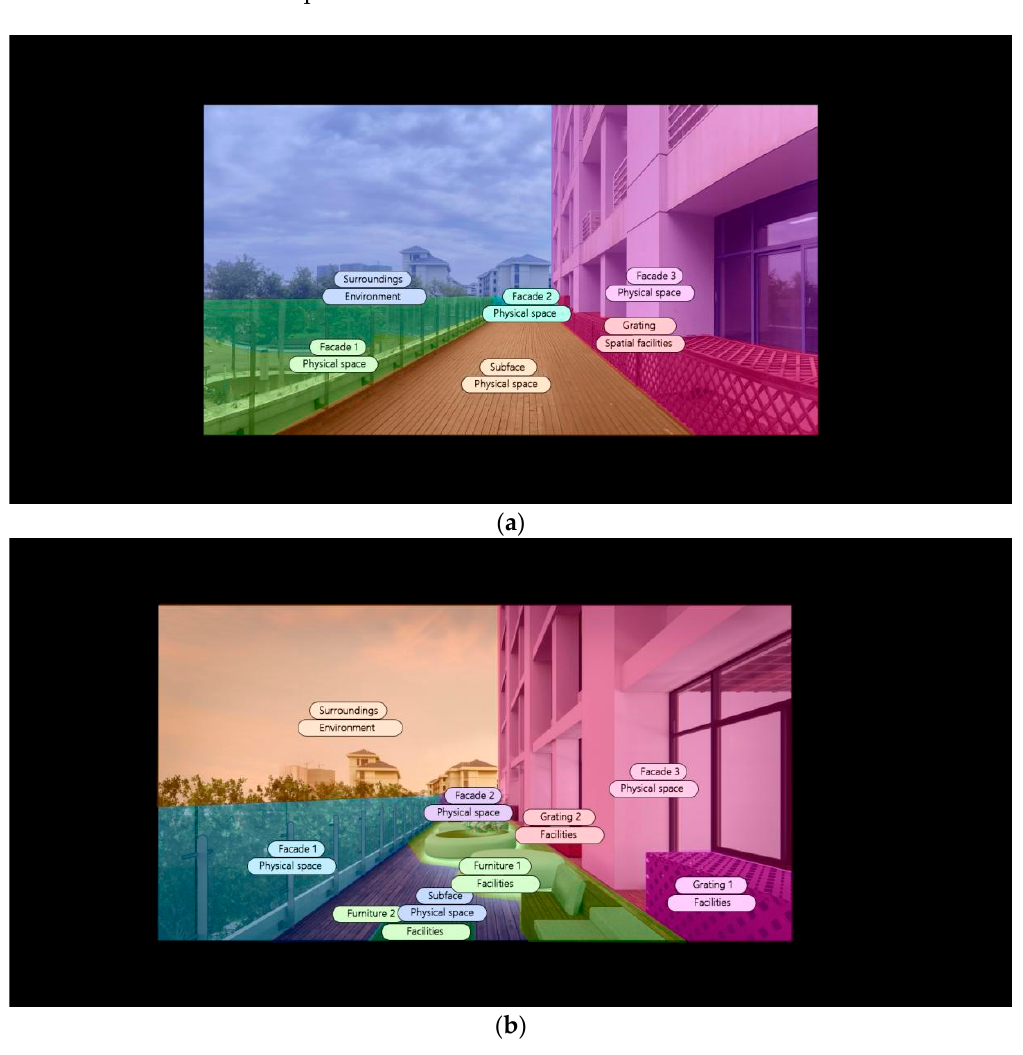
Figure 11. AOI division diagram before and after optimization of the third-floor outdoor terrace.